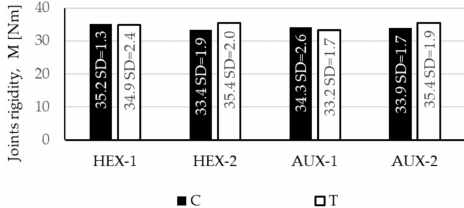
Figure 11. Rigidity of corner joints made of honeycomb panels in compression test (C) and tension test